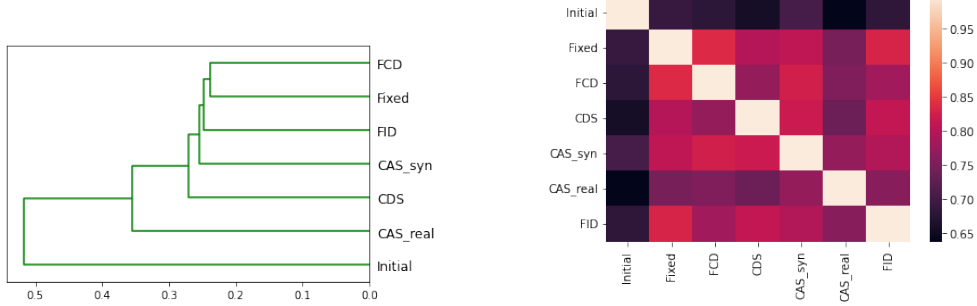
Figure 21. The Pearson correlation heatmap and dendrogram plots of the minority class of the experiments on all black-and-white imagery datasets (mnist-based, fmnist-based, and kmnist-based).